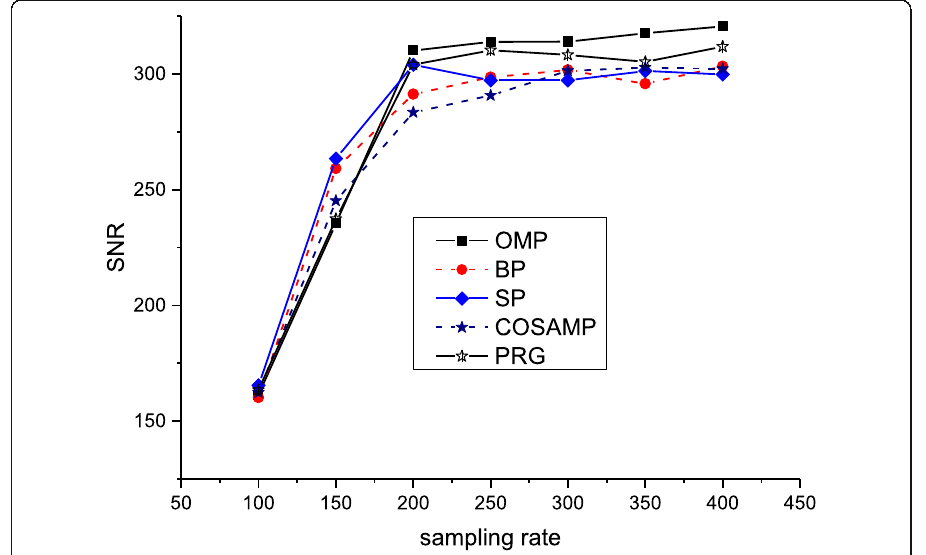
Fig. 4 Reconstruction of sensor signals without noise. The SNR of the reconstructed wireless sensor signal by PRG, OMP, SP, BP, and COSAMP. The sampling rates 100, 150, 200, 250, 300, 350,and 400,